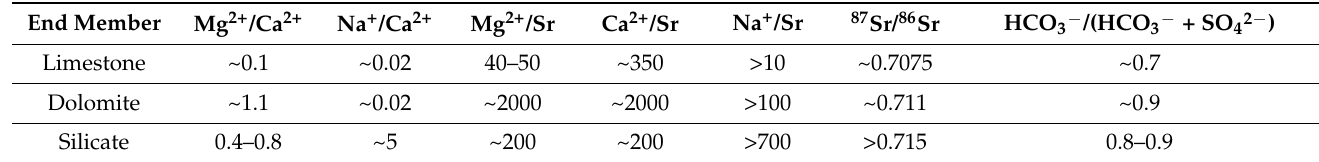
Figure 8. The relationship between the 87 Sr/ 86 Sr and Mg 2+ /Ca 2+ ratios (after correction for atmospheric input based on Han et al., 2010b) in the river water of the main stream and tributaries [44]. Rock end-members are from Zhang et al., 2021 [10]. Ref. (Xu and Liu, 2010) is cited in figure [22]. Table 3. Molar ratios of the river end-members